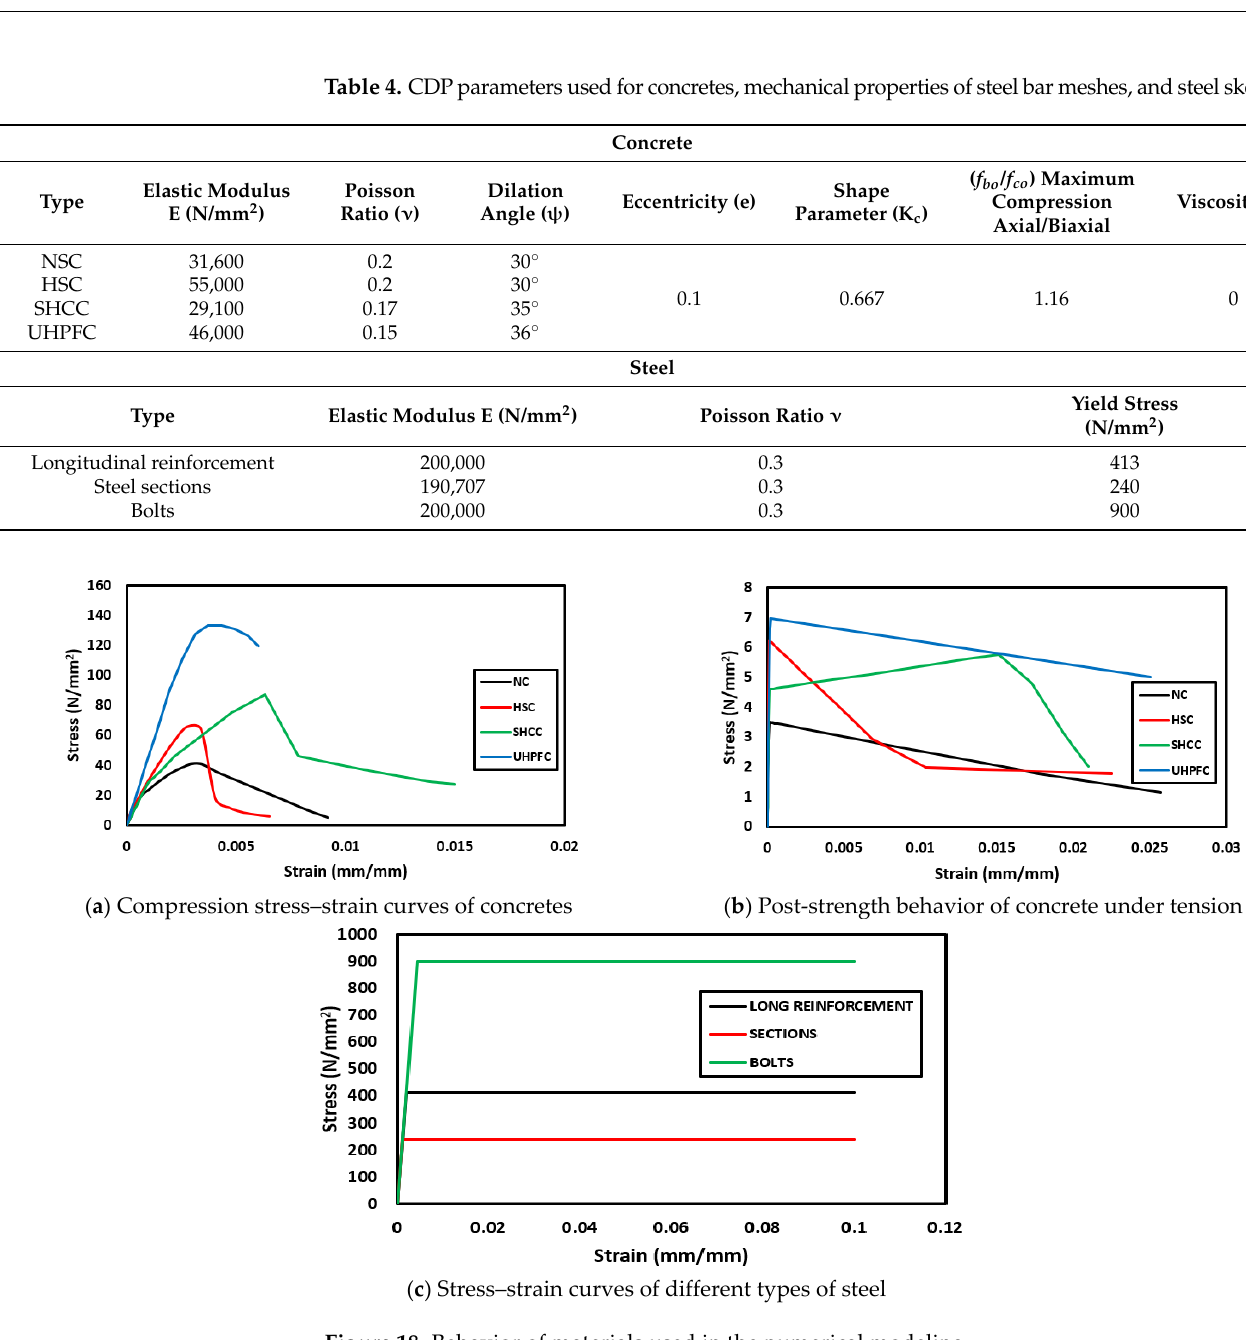
Figure 18. Behavior of materials used in the numerical modeling.